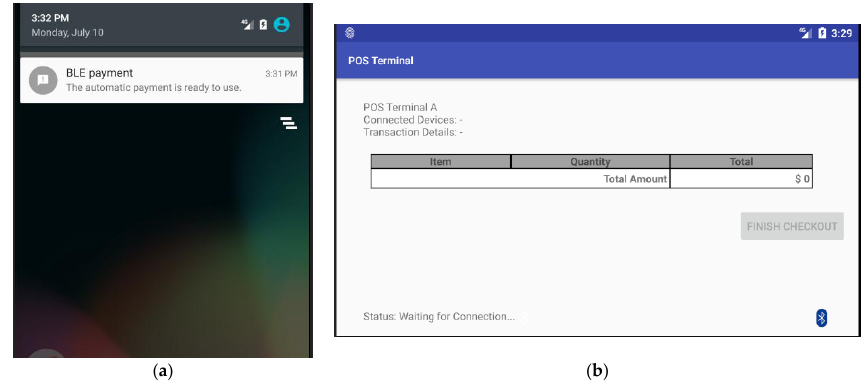
Figure 7. Screenshots of implemented prototype: ( a ) the notification message sent by the payment App executed as an agent process in the customer’s smartphone; and ( b ) the default screen of the POS terminal waiting for incoming BLE connection from a payment App.